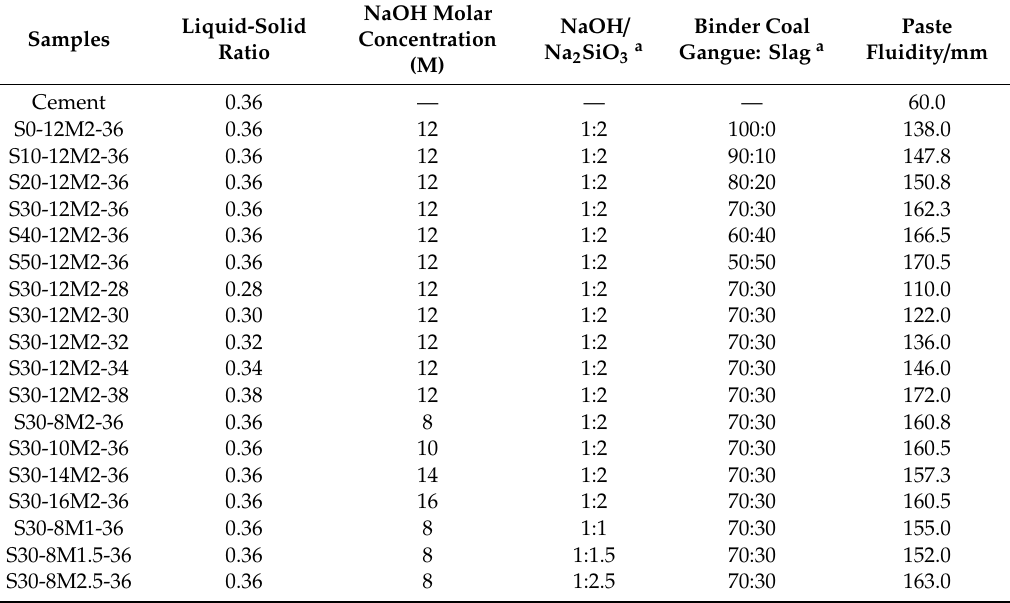
Table 2. Mix proportion of the alkali-activated coal gangue–slag (AACGS) paste. NaOH Molar Liquid-Solid Concentration Samples Ratio